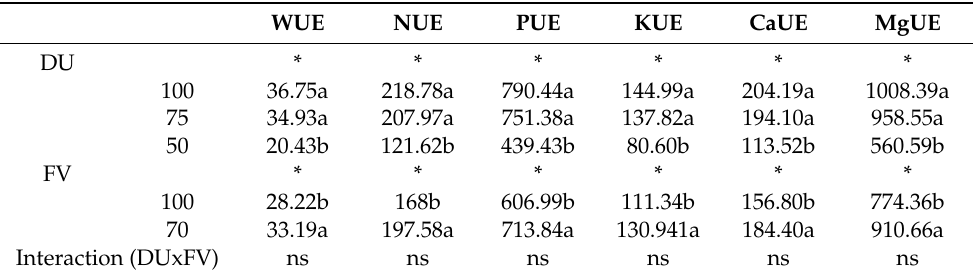
Table 4. Water use e ffi ciency: WUE (expressed in kg of commercial fruit per m 3 of water applied) and nutrient use e ffi ciency, NUE: Nitrogen use e ffi ciency, PUE: Phosphorus use e ffi ciency; KUE: